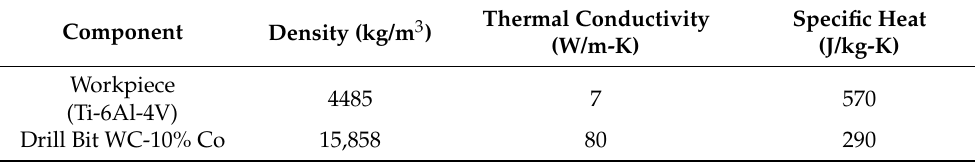
Table 6. Thermal properties of cutting tool and workpiece [45,46].